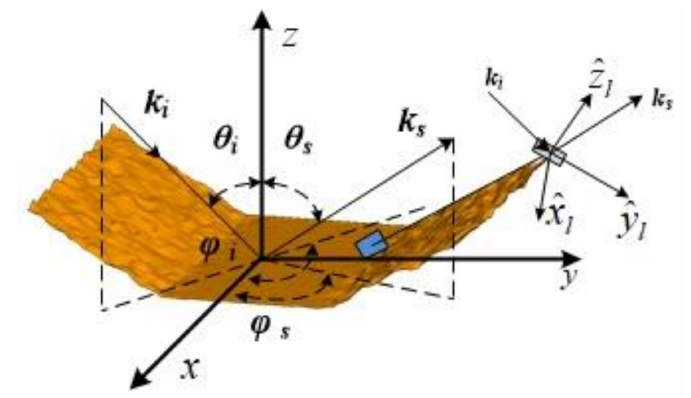
Figure 6. The geometrical configuration of the scattering